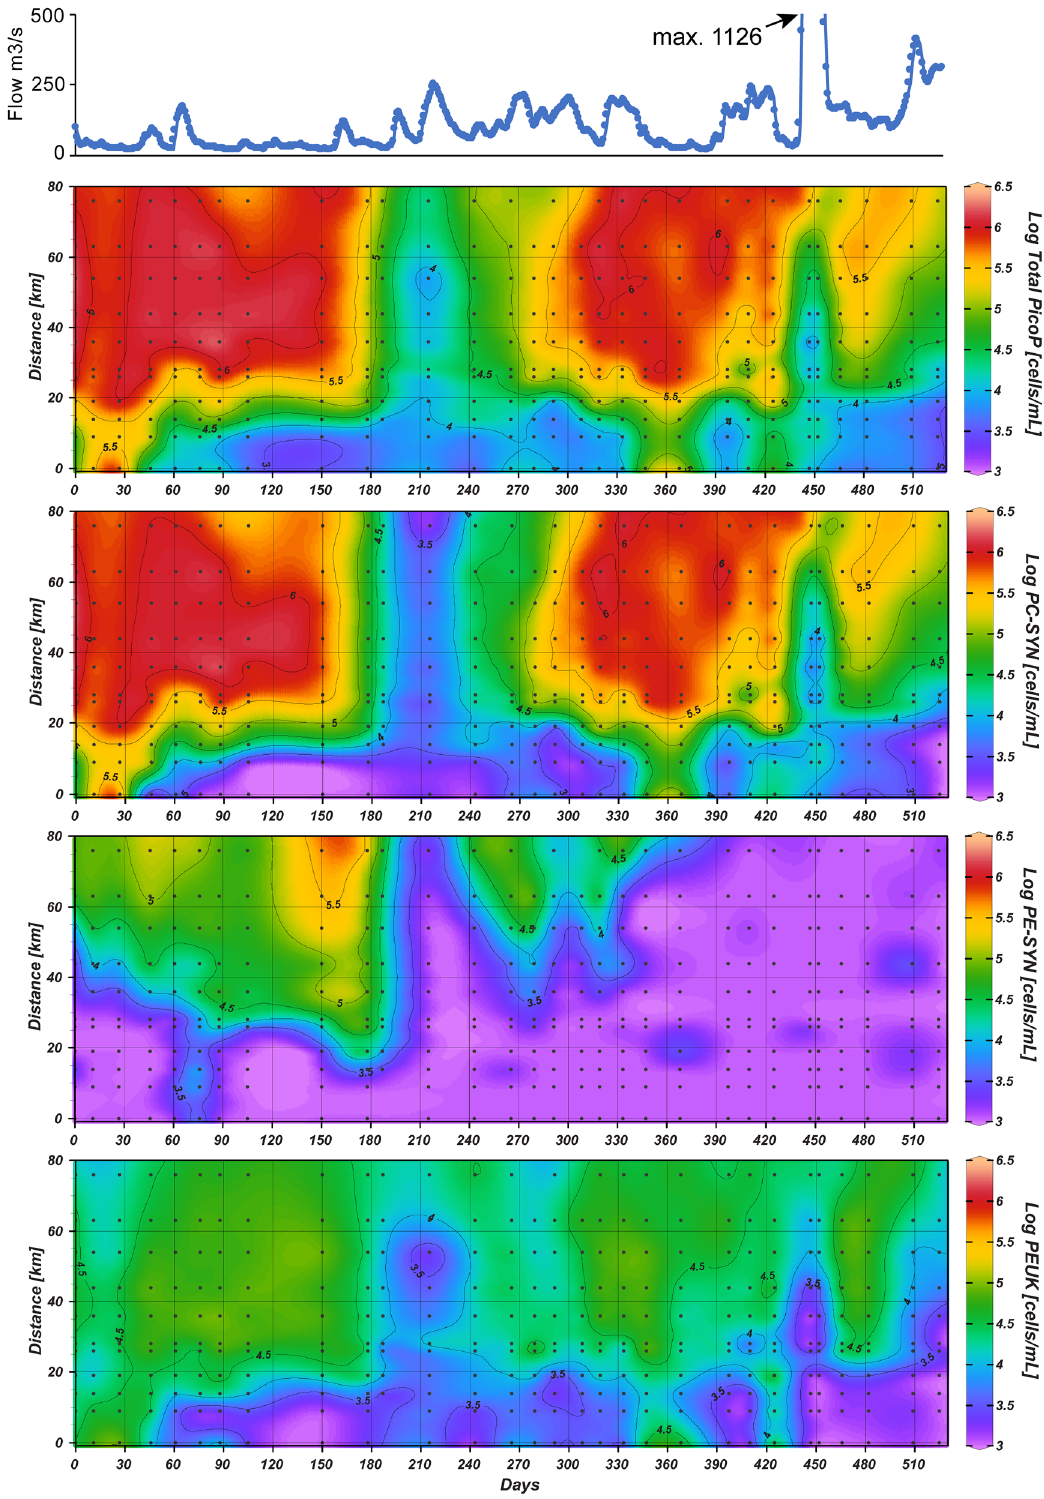
Figure 3. Neuse River flow rate and abundance of total PicoP and morphotypes in the NRE during the